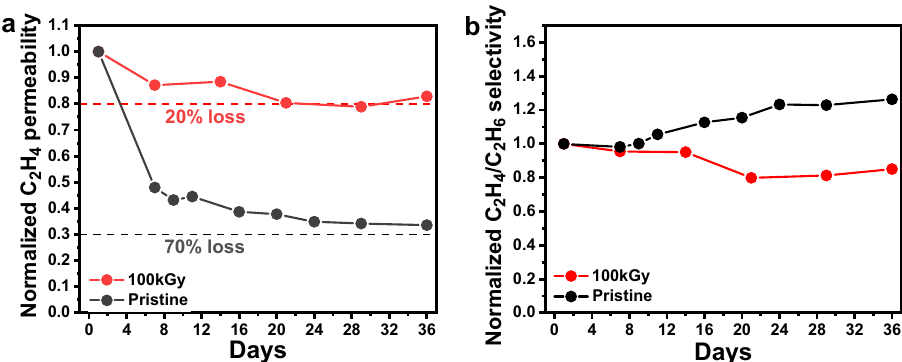
Fig. 5 | Aging tracking of pristine- and 100kGy-CMS membranes. a , b Normalized C 2 H 4 permeability and C 2 H 4 /C 2 H 6 selectivity data versus experimental time (days). Source data are provided as a Source Data fi